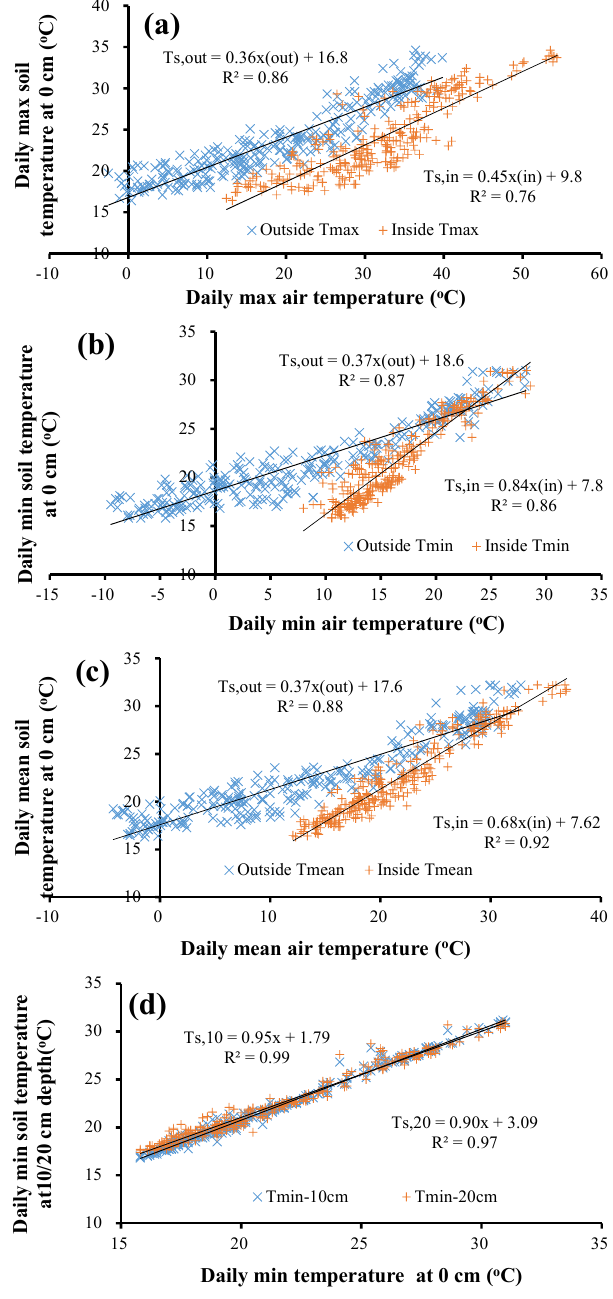
Figure 8. Relationships between daily maximum ( a ), minimum ( b ), and mean ( c ) soil surface temperature to the corresponding daily air temperatures in and out of the sunken solar greenhouse, and the relationships between daily minimum soil temperatures at 10 and 20 cm depth to those at the soil surface inside the sunken solar greenhouse. Ts,in and Ts,out in regression lines are soil temperatures inside and outside, respectively, and corresponding x(in) and x(out) are inside and outside air temperatures, respectively. Ts,10 and Ts,20 in ( d ) are soil temperatures at 10 and 20 cm depth,